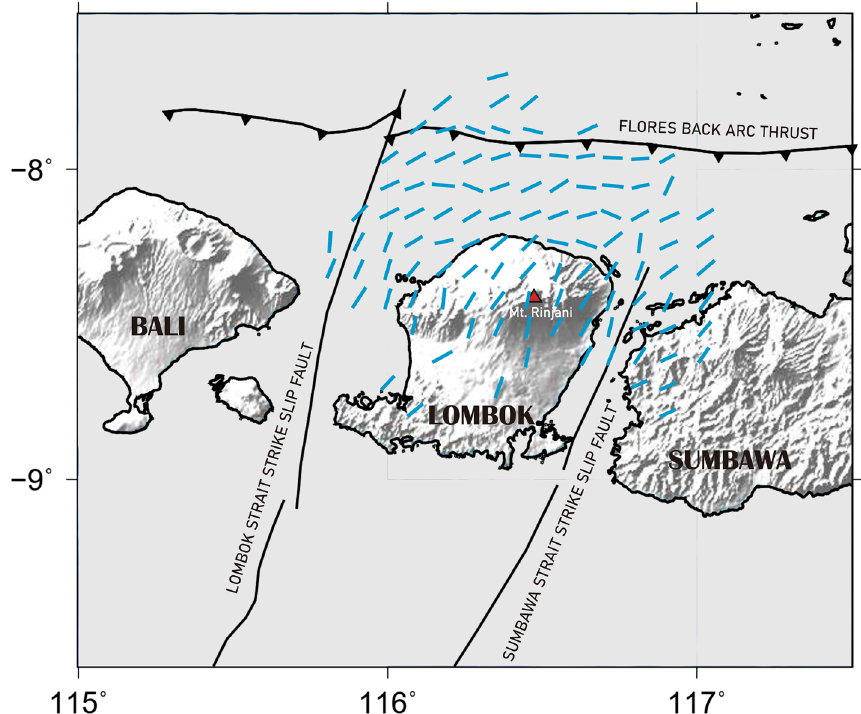
Fig. 5 The distribution of spatially averaged ф in 10